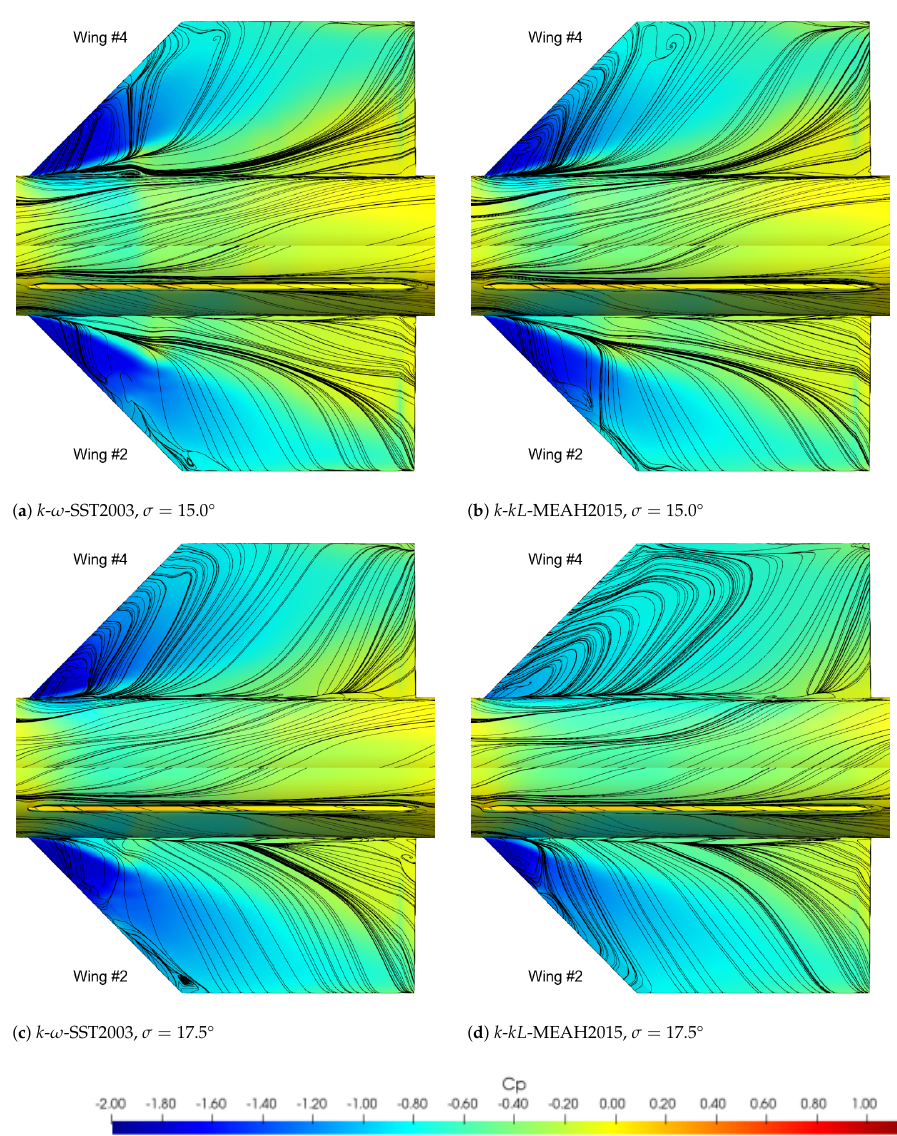
Figure 9. Streamlines and static pressure distributions on leeward sides of Wings 2 and 4; M = 0.85, = 5 × 10 5 , λ = Re d Ref